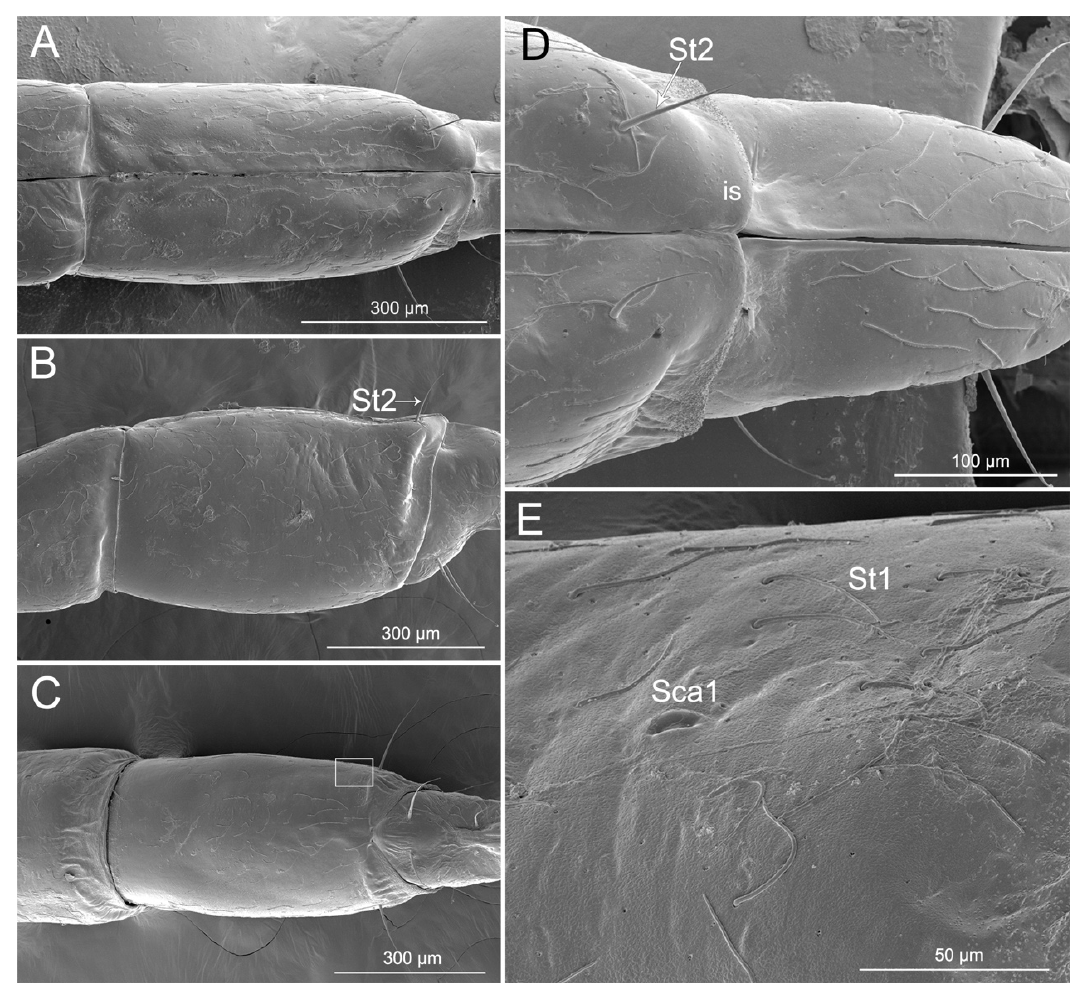
Figure 4. SEM of the third labial segment of Haematoloecha nigrorufa . ( A ). Ventral view; ( B ). Lateral view showing sensilla trichodea (St2); ( C ). Dorsal view; ( D ). Enlarged view of dorsal surface showing sensilla trichodea (St2) and intercalary sclerite (is); ( E ). Enlarged view of box in ( C ), showing sensilla campaniformia (Sca1) and sensilla trichodea (St1).